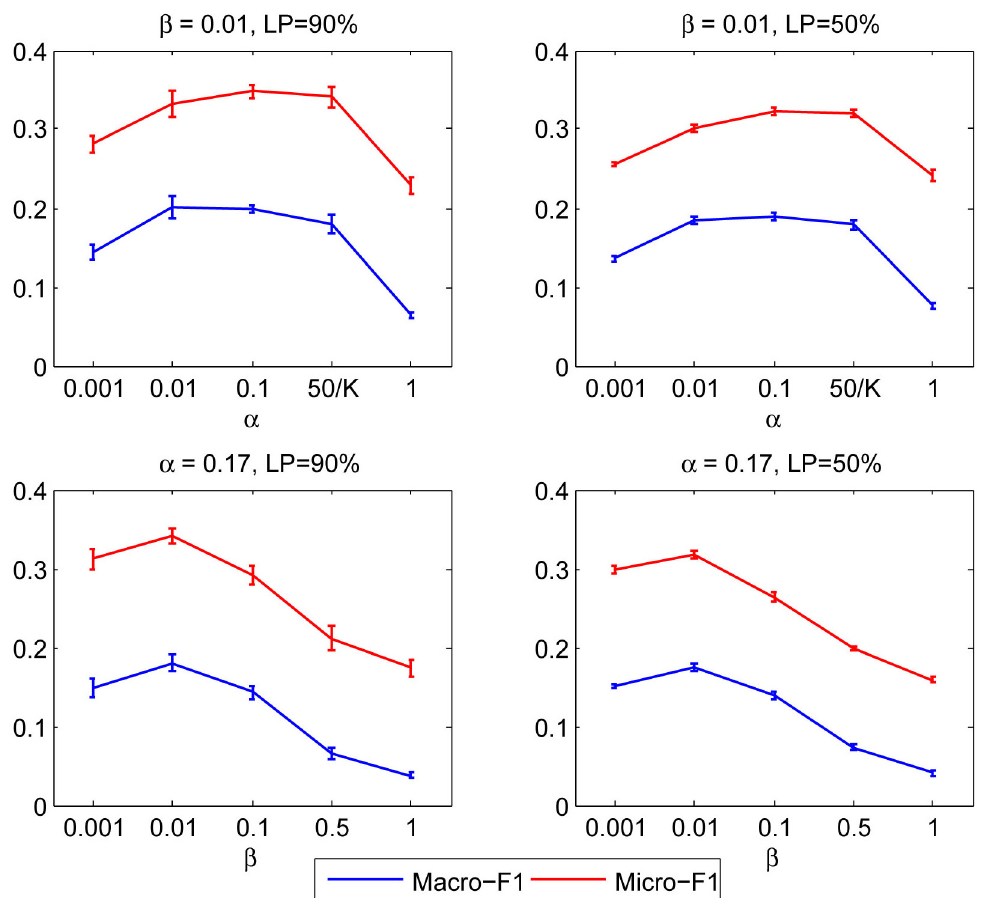
Fig 3. Performance of BBSD on different